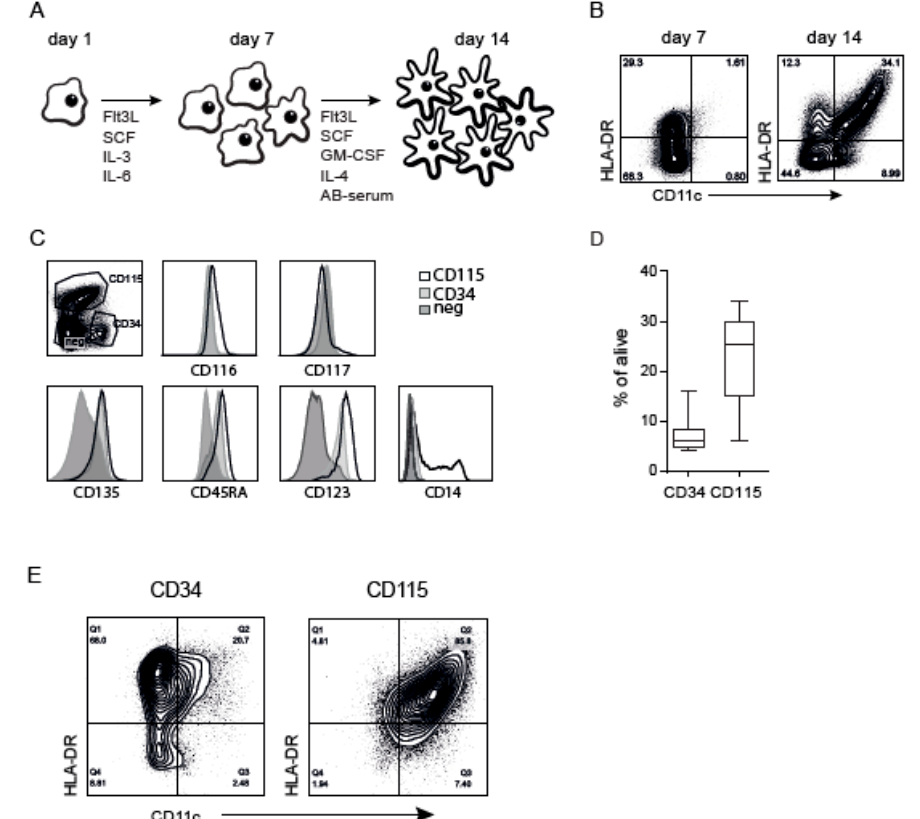
Figure 1. Cord blood (CB)-derived dendritic cell (DC) (CB-DC) culture containing different myeloid progenitors. ( A ) Schematic overview of the culture protocol for the generation of the backbone CB-DC. ( B ) CD11c and HLA-DR expression using flow cytometry after expansion (day 7) and after differentiation (day 14) within the CB culture. ( C ) Identification of DC progenitors after the expansion phase based on CD34, CD115. CD116, CD117, CD135, CD45RA, CD123, and CD14 expression compared between CD115 + , CD34 + , and the remaining population (negative). ( D ) Percentage of the presence of the progenitors in the CB culture. ( E ) The expression of CD11c and HLA-DR after differentiating the sorted progenitors in differentiation medium. Data represent at least five independent experiments.